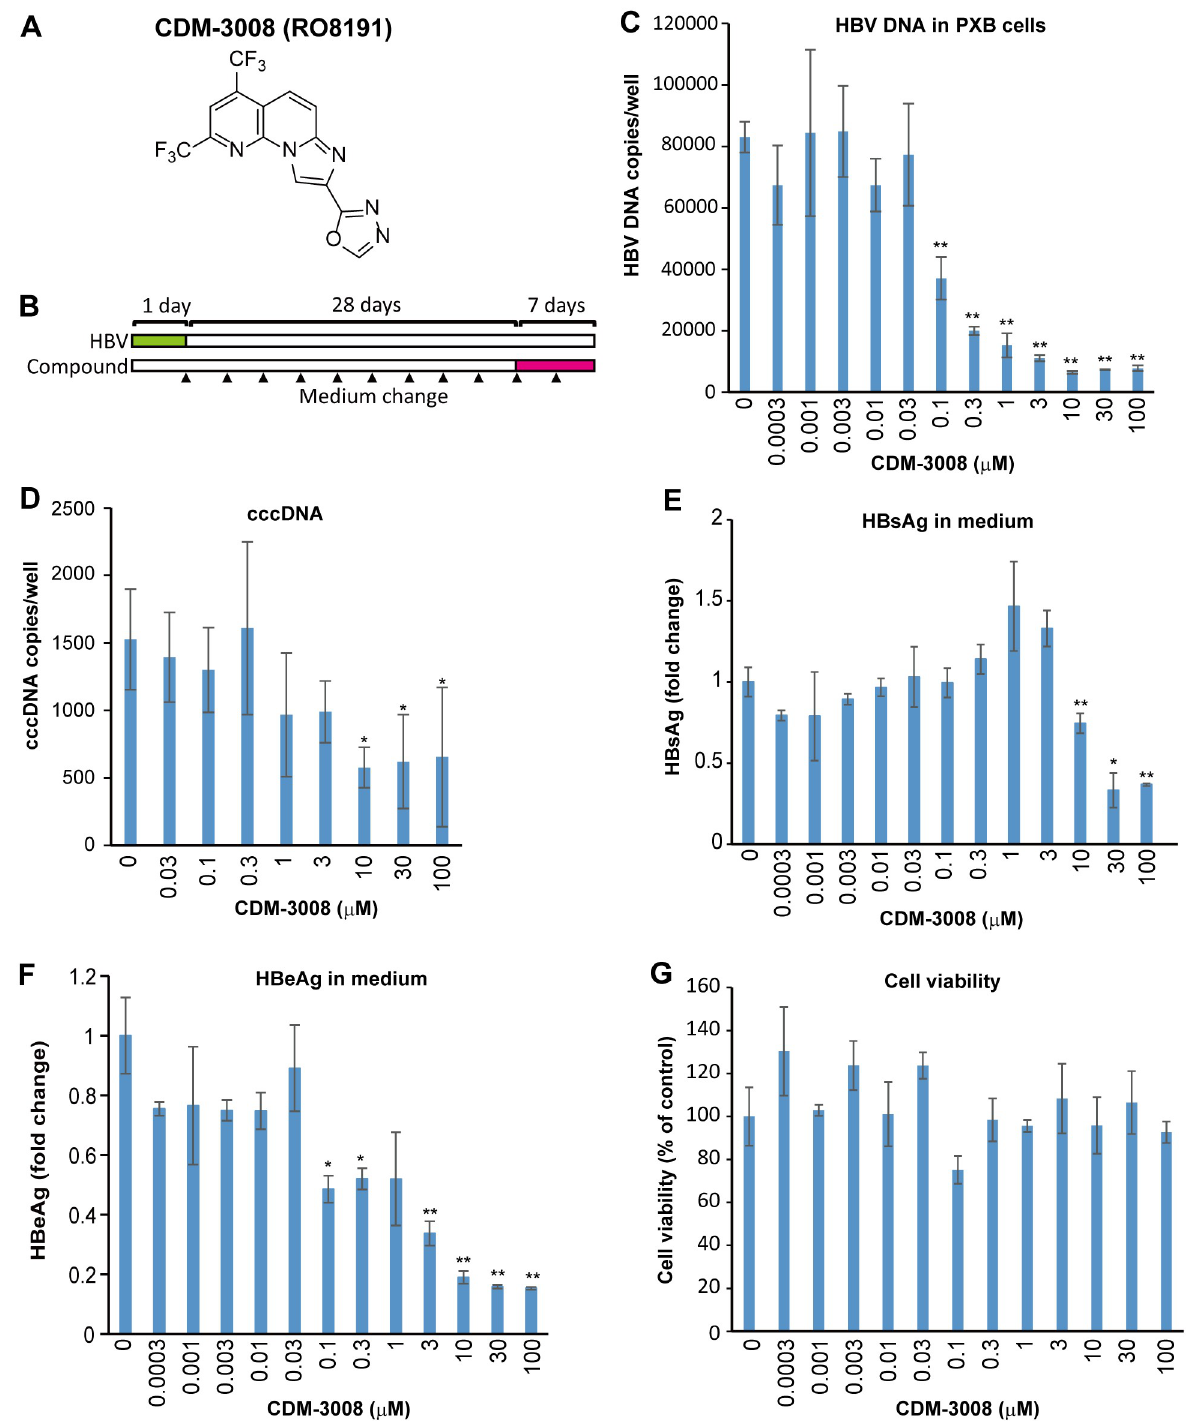
Fig 1. Anti-HBV activity of CDM-3008 in primary cultured human hepatocytes. (A) The chemical structure of CDM-3008. (B) The schematic experimental design of the anti-HBV activity analysis. Primary cultured human hepatocytes (PXB cells) were infected with HBV genotype C for 1day (green) and cultured for 28 days, and the cells were then treated with 0–100 μ M CDM-3008 for 7 days (magenta). The black triangles show the time points of medium changes. (C) Measurement of HBV DNA copies in PXB cells after 7 days of CDM-3008 treatment. HBV DNA was decreased with 0.1–100 μ M CDM-3008 in a dose-dependent manner. (D) Measurement of cccDNA copies after T5 exonuclease treatment. cccDNA was significantly decreased with 10–100 μ M CDM-3008. Error bars indicate S.D. in D (n = 3). � , p < 0.05 (one-tailed t -test) in D. (E) HBsAg levels are